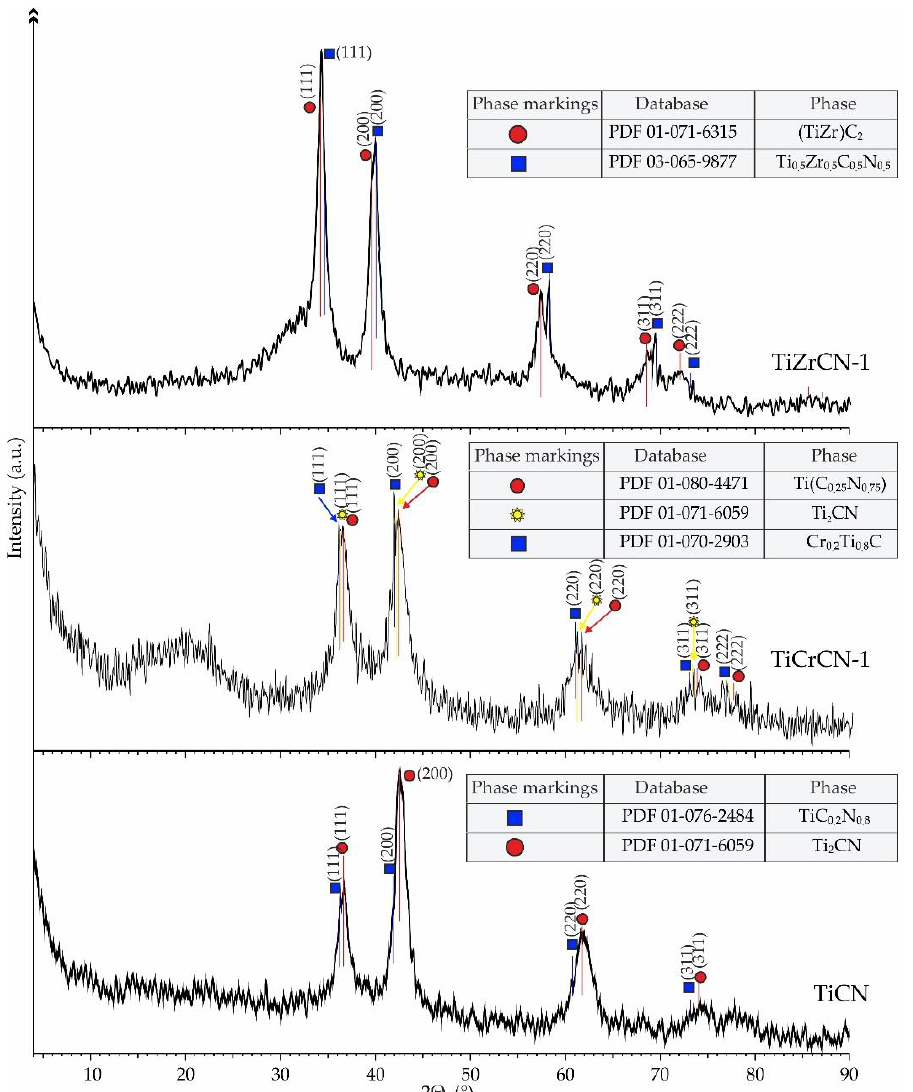
Figure 5. XRD patterns obtained for TiCN, TiCrCN-1, and TiZrCN-1 coatings.